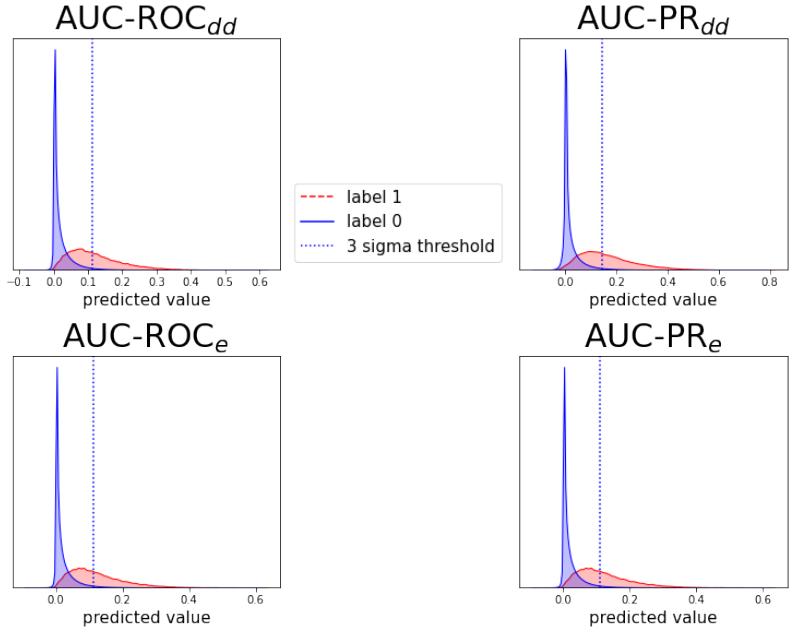
Figure A7. Analogous to Figure A6, for prediction task (cid:99) dde